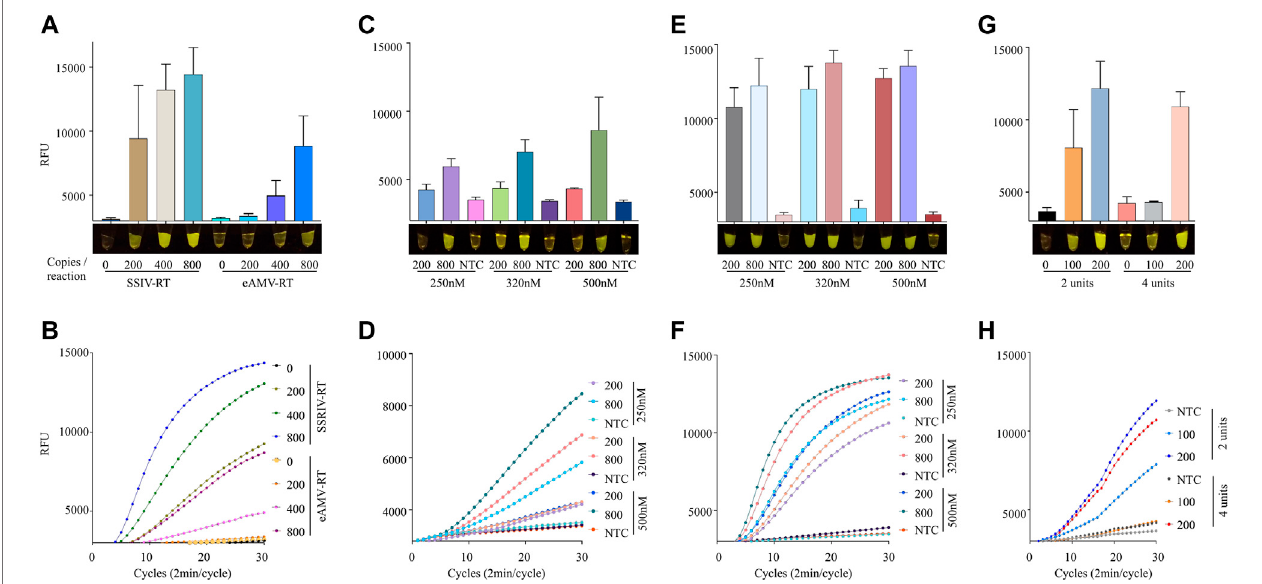
FIGURE 4 | Ef fi cient one-pot detection of synthetic SARS-CoV-2 RNA by iSCAN-V2 using SSIV-RT. (A) The ef fi cacy of SSIV-RT and eAMV-RT was compared. Fourunits/reactionofeAMV-RTorSSIV-RTwereusediniSCAN-V2assaystodetectsyntheticSARS-CoV-2RNA(200,400,and800copies/reaction).Thesameprimer concentration(320 nM)wasusedinallreactions. (B) Real-timerepresentationofiSCAN-V2assaysusingeAMV-RTandSSIV-RTshownin (A) . (C) TheiSCAN-V2assay was performed with eAMV-RT using different concentrations of primers (250, 320, and 500 nM) for the detection of synthetic SARS-CoV-2 RNA at 200 and 800 copies/reaction. (D) Real-time representation of iSCAN-V2 assays using eAMV-RT shown in (C) . (E) The iSCAN-V2 assay was performed with SSIV-RT using different concentrations of primers (250, 320, and 500 nM) for the detection of synthetic SARS-CoV-2 RNA at 200 and 800 copies/reaction. (F) Real-time representation of iSCAN-V2 assays using SSIV-RT shown in (E) . (G) The iSCAN-V2 assay was carried out with 2 or 4 units of SSIV-RT. H. Real-time representation of iSCAN-V2 assays using 2or 4units ofSSIV-RT shown in (G) .CFX96 (Bio-Rad) end-point fl uorescence readouts were converted to graphical formatusing GraphPadPrism. Forend-point fl uorescence data presentation, error bars (cid:1) means ± SD ( n (cid:1) 3). End-point fl uorescence was imaged in a P51 molecular fl uorescence viewer. For real-time representation, the intensity of the fl uorescent signal was measured every 2 min for a period of 1 h. Values shown in the graphs are means of 3 independent readings. NTC, no template